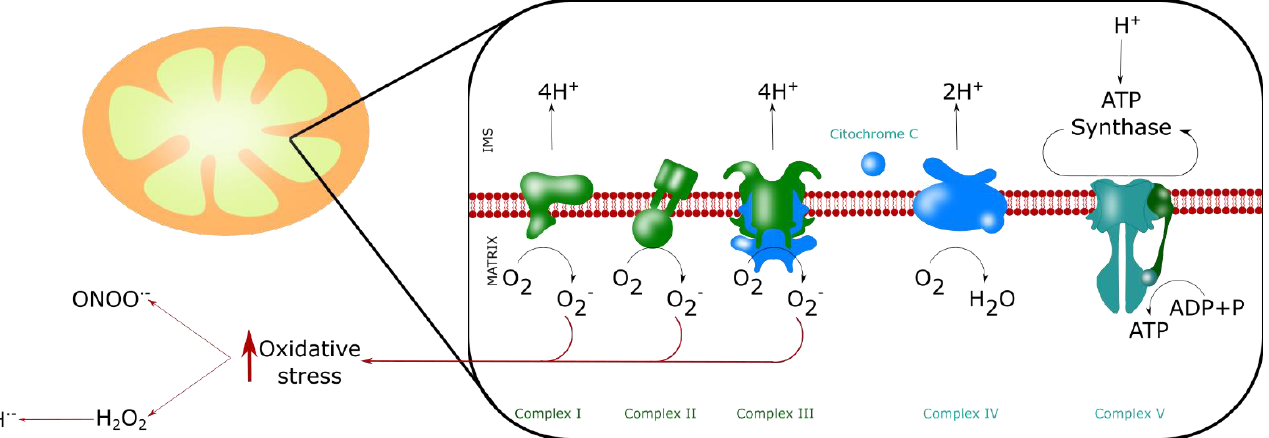
Figure 5. ROS production by mitochondria. Mitochondria produce ROS, mainly superoxide anion O 2.- by the MRC (at the complexes I, II and III), and indirectly hydroxyl radical (OH . ), hydrogen peroxide (H 2 O 2 ) andperoxynitrite (ONOO - ). These four molecules are the main reactive agents inducing nitro-oxidative stress.